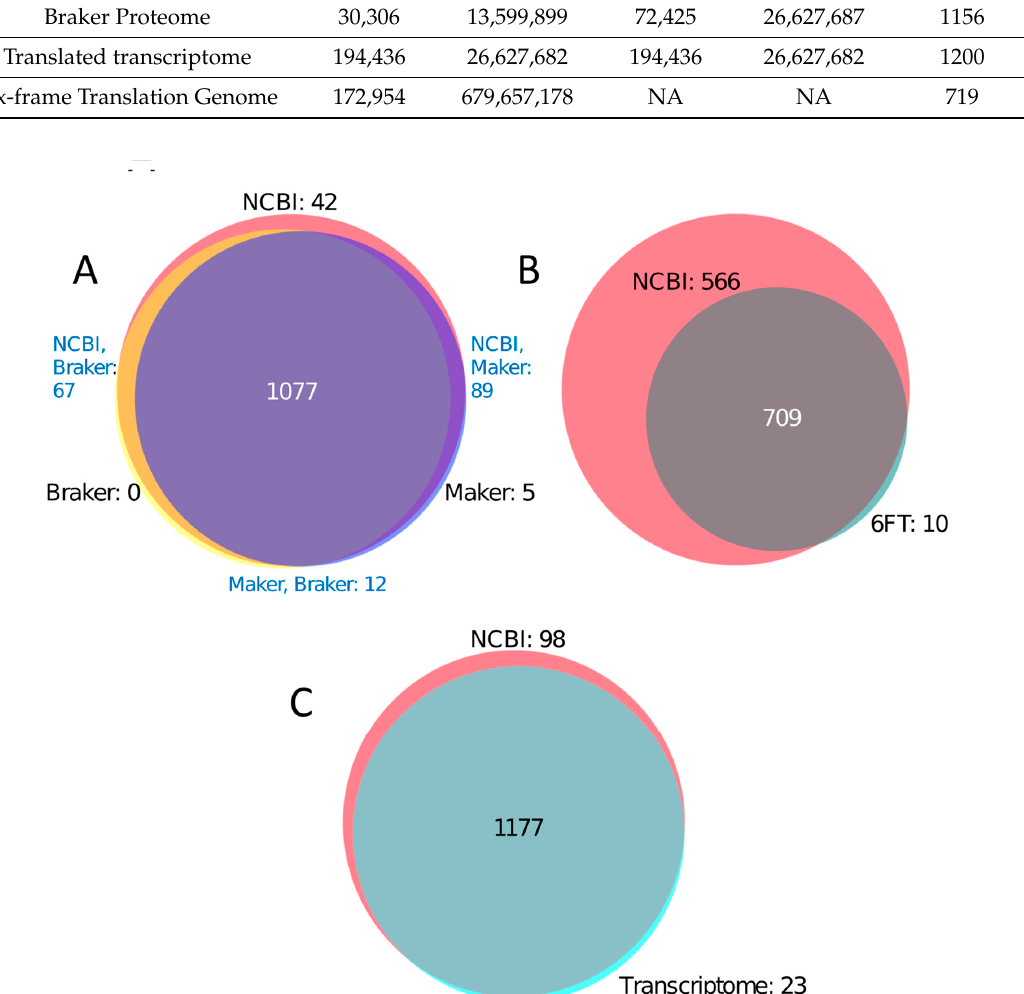
Figure 2. Venn diagrams comparing the total number of peptides identified in five databases. Number of unique peptides listed, along with the number of peptides shared by all databases. ( A ). NCBI, Maker, and Braker databases, ( B ). NCBI and 6FT databases, ( C ). NCBI and Transcriptomic databases.